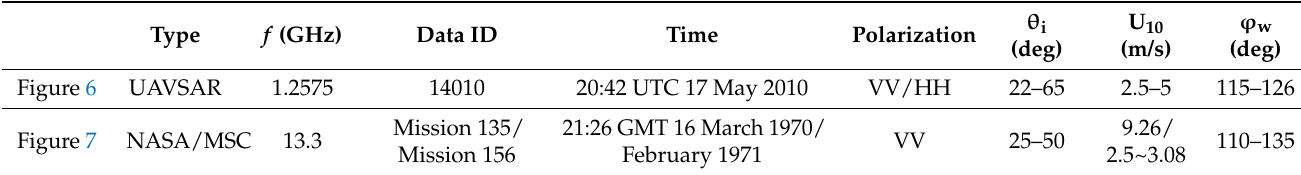
The simulation parameters of Figure 6 are as follows: f = 1.2575 GHz and U 10 = 4 m/s. Equation (6) shows that the relative dielectric parameters of the oil spill is ε oil = (2.96, 0.04) (mixture of 80% oil and 20% water), the seawater is ε sea = (72.6, 69), and ϕ w = 120 ◦ expresses the wind direction. The calculation size of the sea surface is 300 m × 300 m, and the interval sample is 1 m × 1